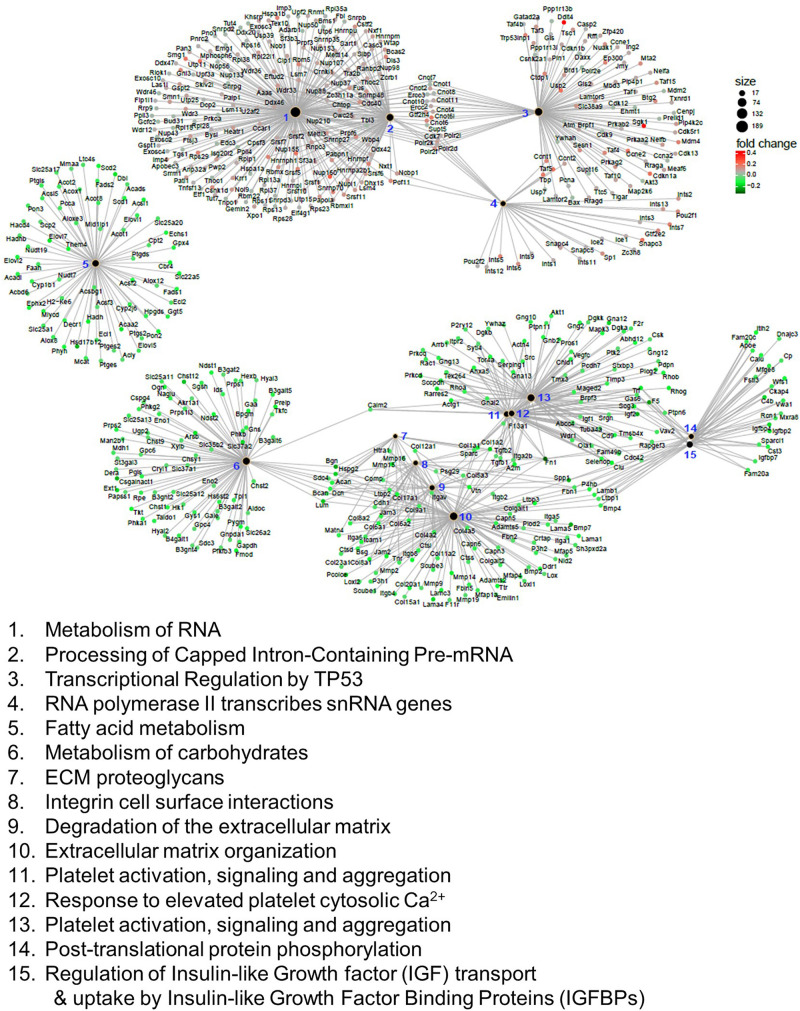
Reactome analysis of genes correlated with manganese (Mn)-deficient cerebellum. Enrichment of reactome categories, as calculated with the gene set enrichment analysis (GSEA) algorithm. Among the 62 reactomes (Padj < 0.05), the top 15 reactomes based on Padj values are represented. The size of the black dots indicates the number of genes involved in the reactome. Genes involved in the reactome are colored based on the mRNA changes in the Mn-deficient cerebellum. Reactomes can be interconnected via genes that belong to multiple reactomes.